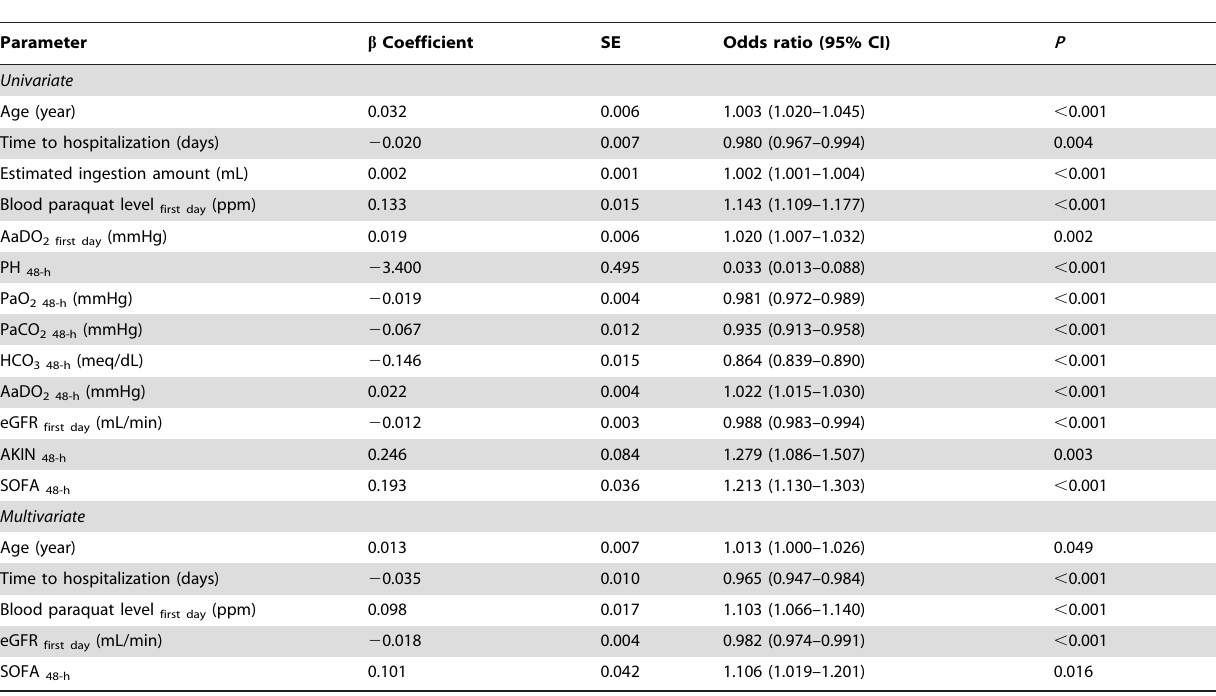
Table 6. Analysis of mortality using univariate and multivariate logistic regression models (n =187).